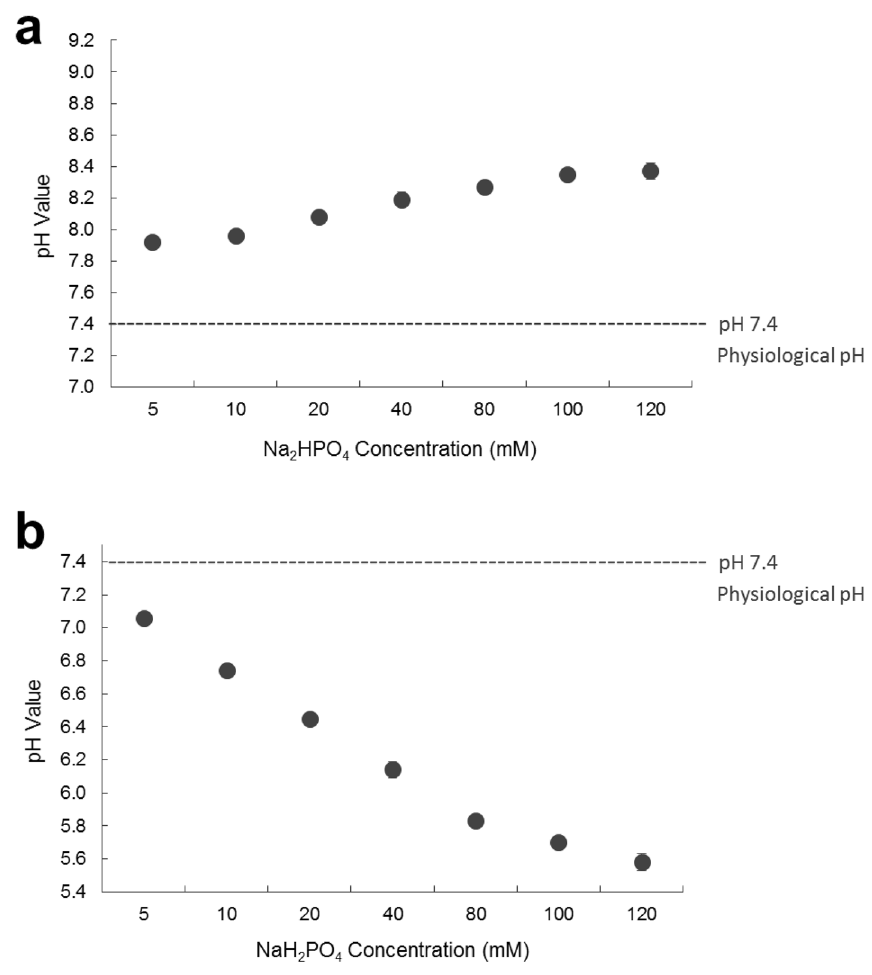
Figure 6. Measured pH values for different concentrations of ( a ) Sodium phosphate dibasic and ( b ) Sodium phosphate monobasic prepared in cell culture media. As the concentration of HPO 4 2− increases, the pH of the solutions increases. As the concentration of H 2 PO 4 − increases, the pH of the solutions